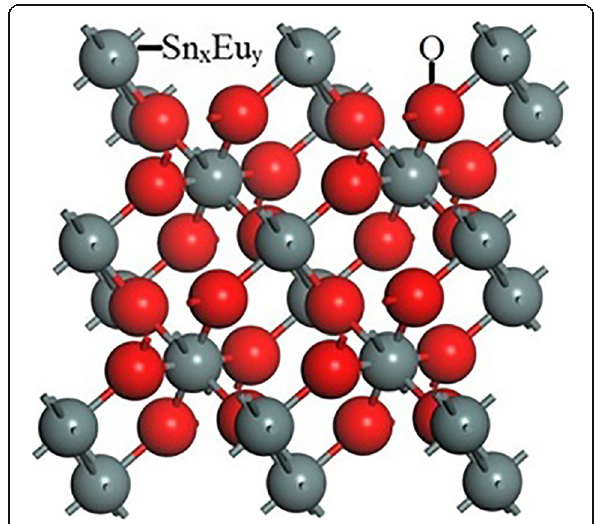
Fig. 2 Structure diagram of Sn x Eu y O 16 ( x = 8, y = 0 for SnO 2 and x = 7.94, y = 0.06 for Eu-SnO